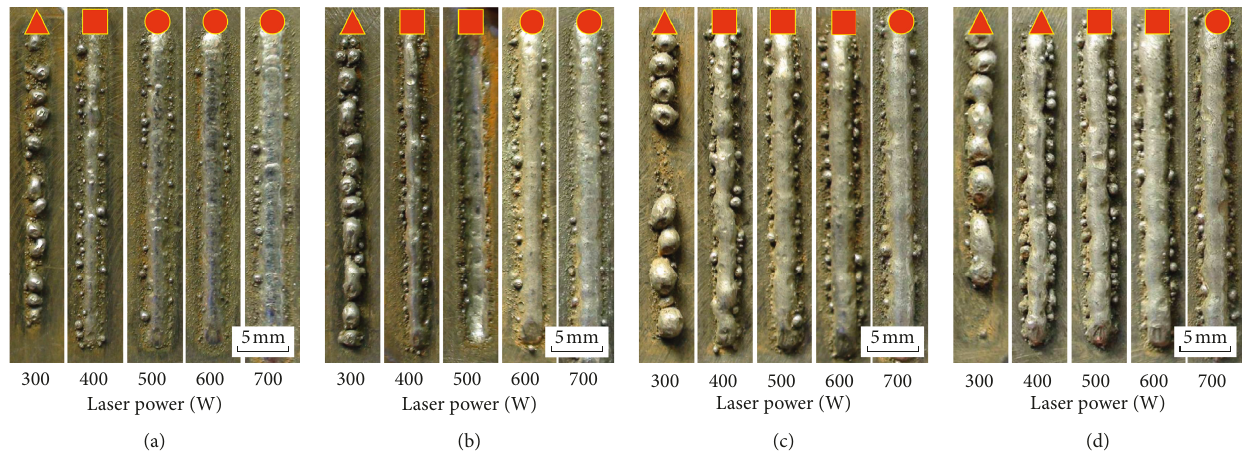
Figure 4: Surface morphology of laser tracks at the scanning velocity of 5 mm/s with various laser powers and powder feed rates of (a) 1.67 g/min, (b) 2.56 g/min, (c) 3.45 g/min, and (d) 4.33